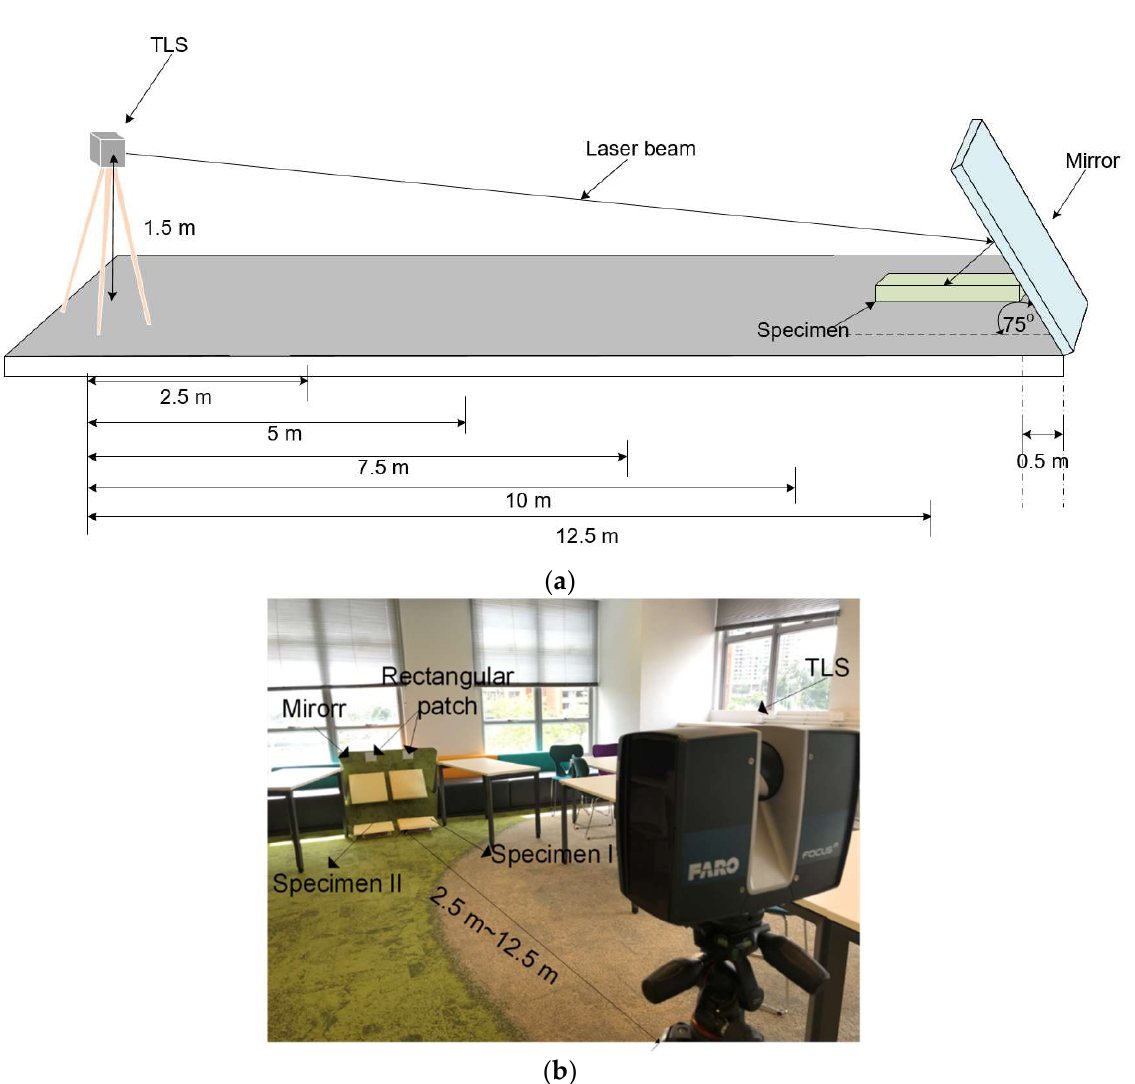
Remote Sens. 2021 , 13 , x FOR PEER REVIEW Figure 5. Test configuration of experiment I ( a ) side view of the test set up and ( b ) 3D view of the setup.